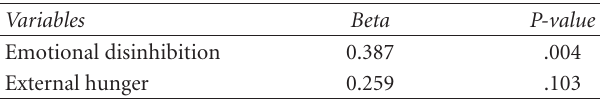
Table 3: Independent predictors of BMI in women with lower physical activity participation ( n = 64).